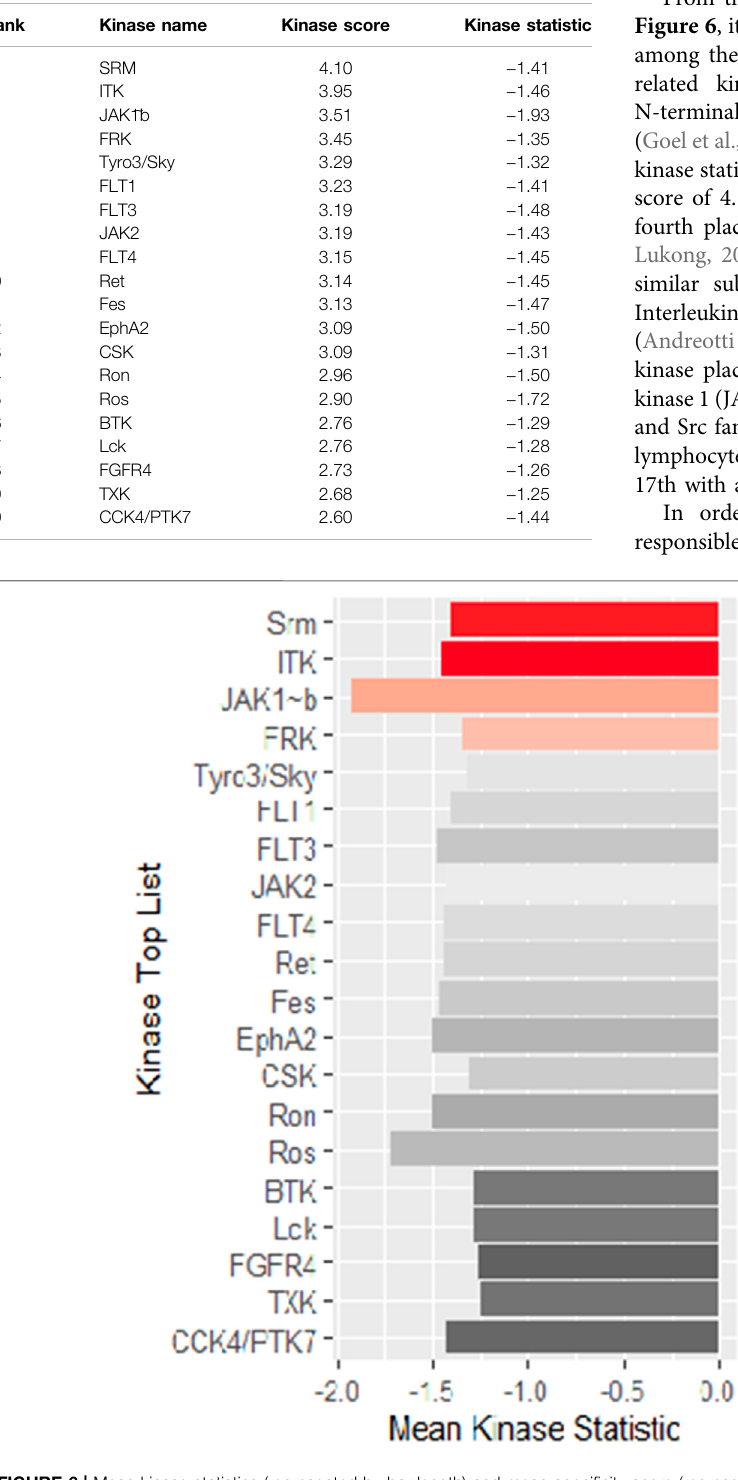
TABLE 2 | Top 20 affected kinases ranked according to kinase scores for KIM- 161 at 0.1 µM treatment of HL60 leukemia